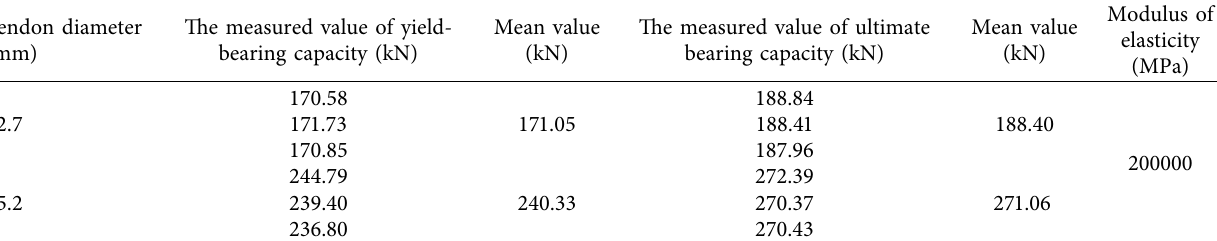
Table 2: Performance test results of prestressing